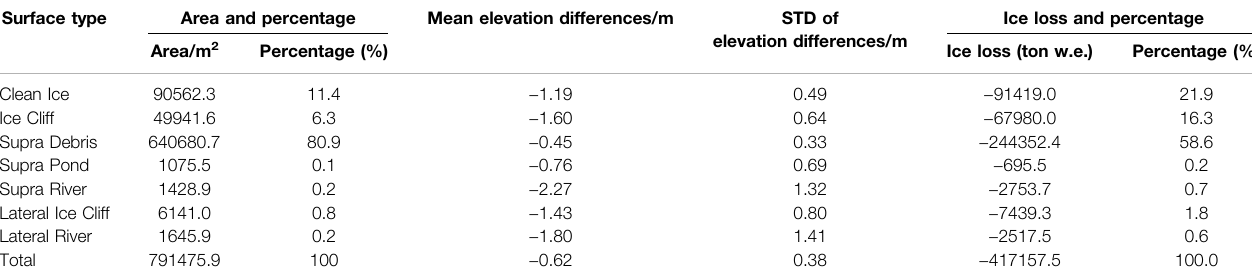
TABLE 1 | The statistics of surface elevation change and corresponding ice loss for different surface types. Surface type Area and